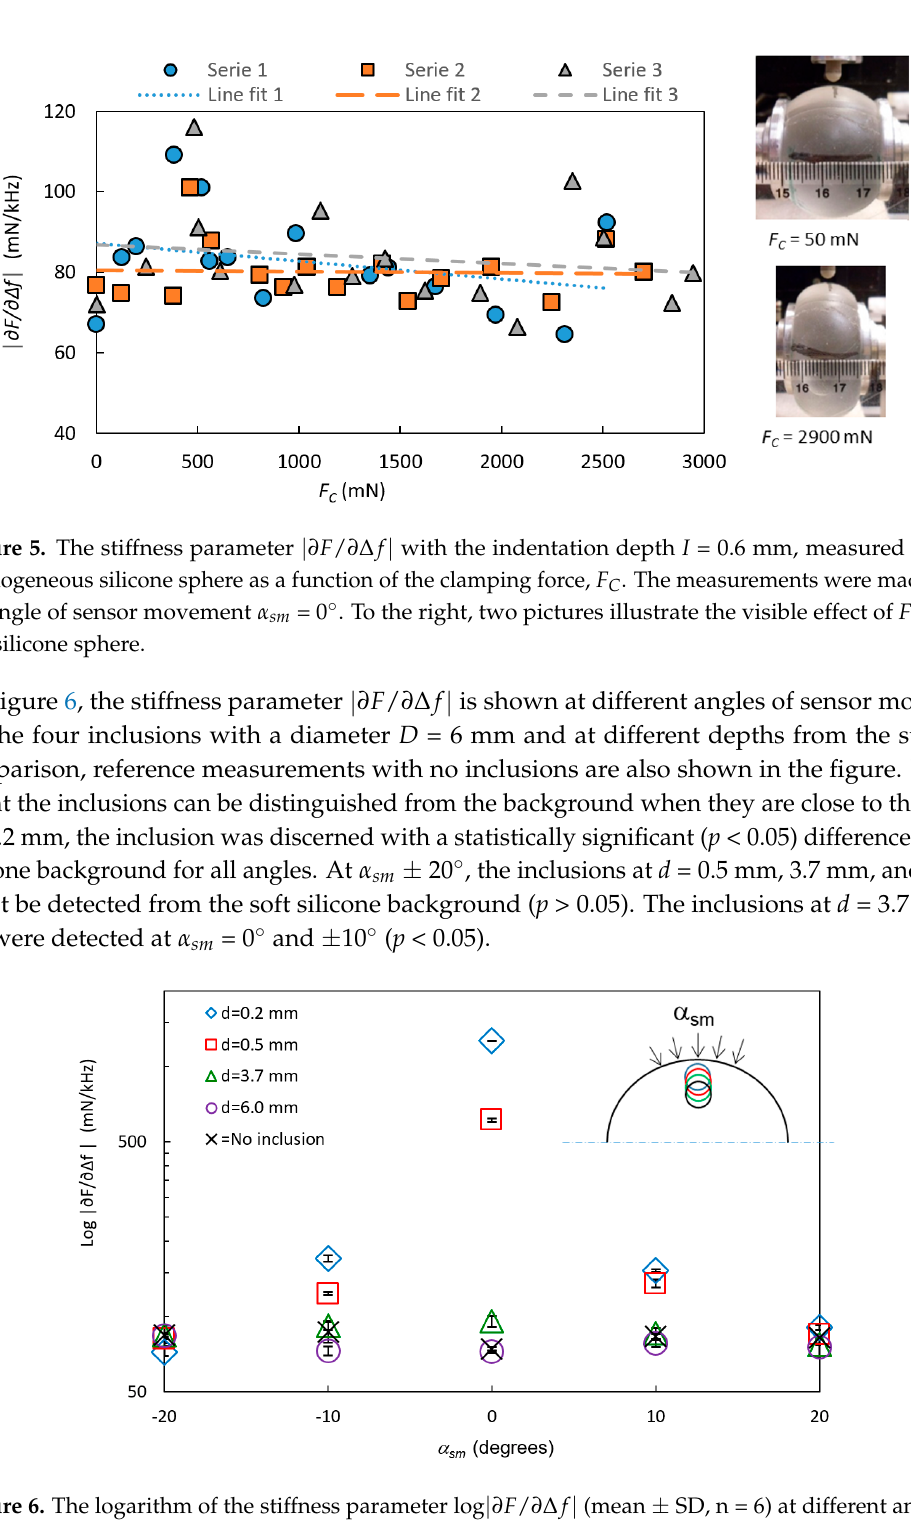
Figure 6. The logarithm of the stiffness parameter log |(cid:2034)(cid:1832) (cid:2034)∆(cid:1858)⁄ | (mean ± SD, n = 6) at different angles of sensor movements α sm (see insert) on silicone spheres with inclusions with the diameter D = 6 mm but at different depths, d . Measurements made between the inclusions are marked “No inclusions”. The standard deviations (SD < 8.4 mN/kHz) are included in the graph.